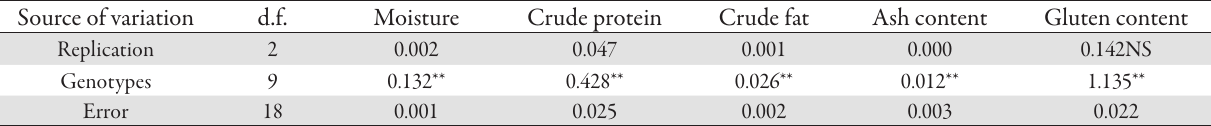
Tab. 3. Analysis of variance of quality traits in ten wheat genotypes under water stress conditions Source of